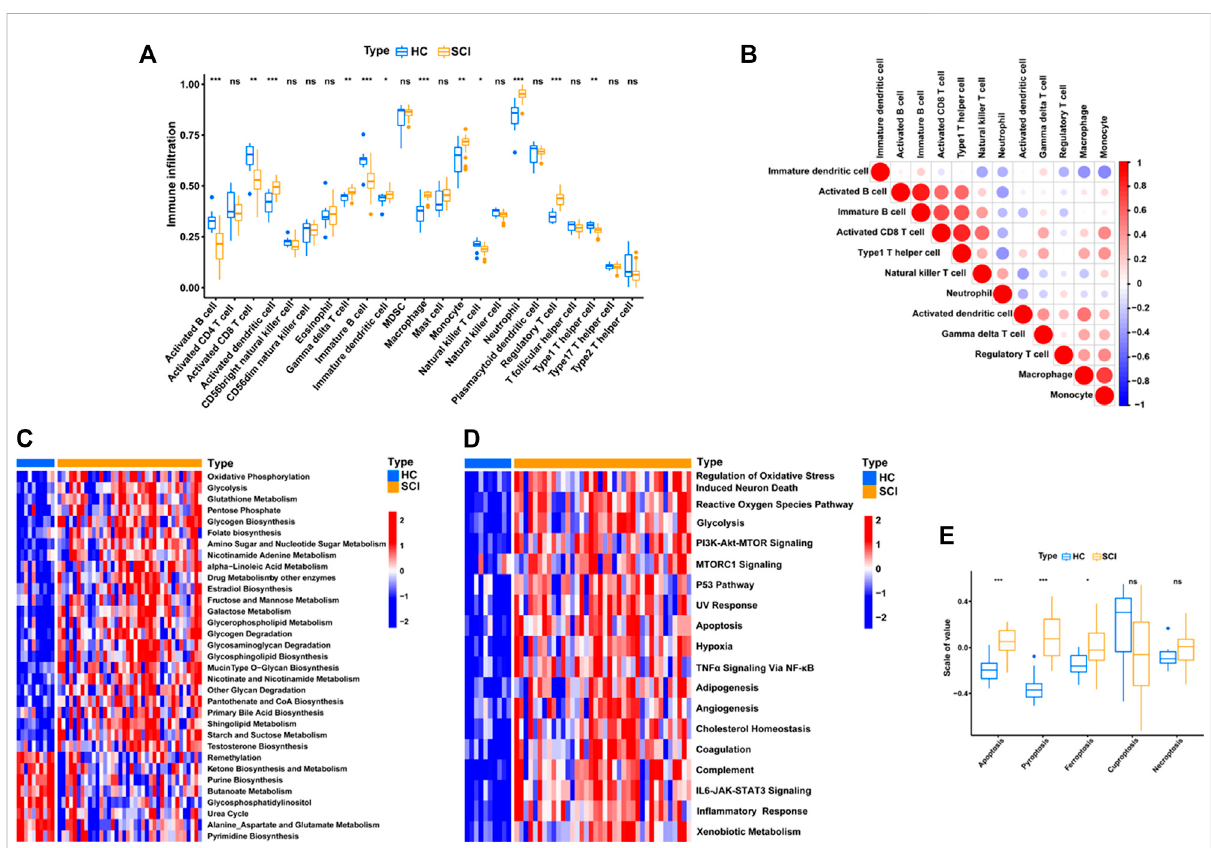
Identify immunological, metabolic, and biological features of SCI. (A) Box plot shows the abundance and difference of 23 immune cell types between SCI and HC groups. P values were showed as: ns, not signi fi cant; * p < 0.05; ** p < 0.01; *** p < 0.001. (B) Correlation matrix for all 12 differential immune cell proportions. Negative correlations are marked in blue and positive correlations are marked in red. (C – D) Heatmap of GSVA results showing GSVA scores of the metabolic pathways and hallmark gene set. (E) This boxplot shows an overview of the levels of cell death-relatedpathwayactivationbetweentheSCIandHCgroups,includingferroptosis,pyroptosis,apoptosis,cuproptosisandnecroptosis. P values were showed as: ns, not signi fi cant; * p < 0.05; *** p <